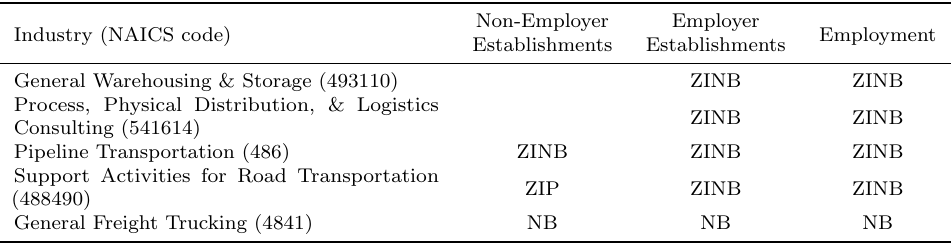
Table 2: T&W sector distributions across industry size